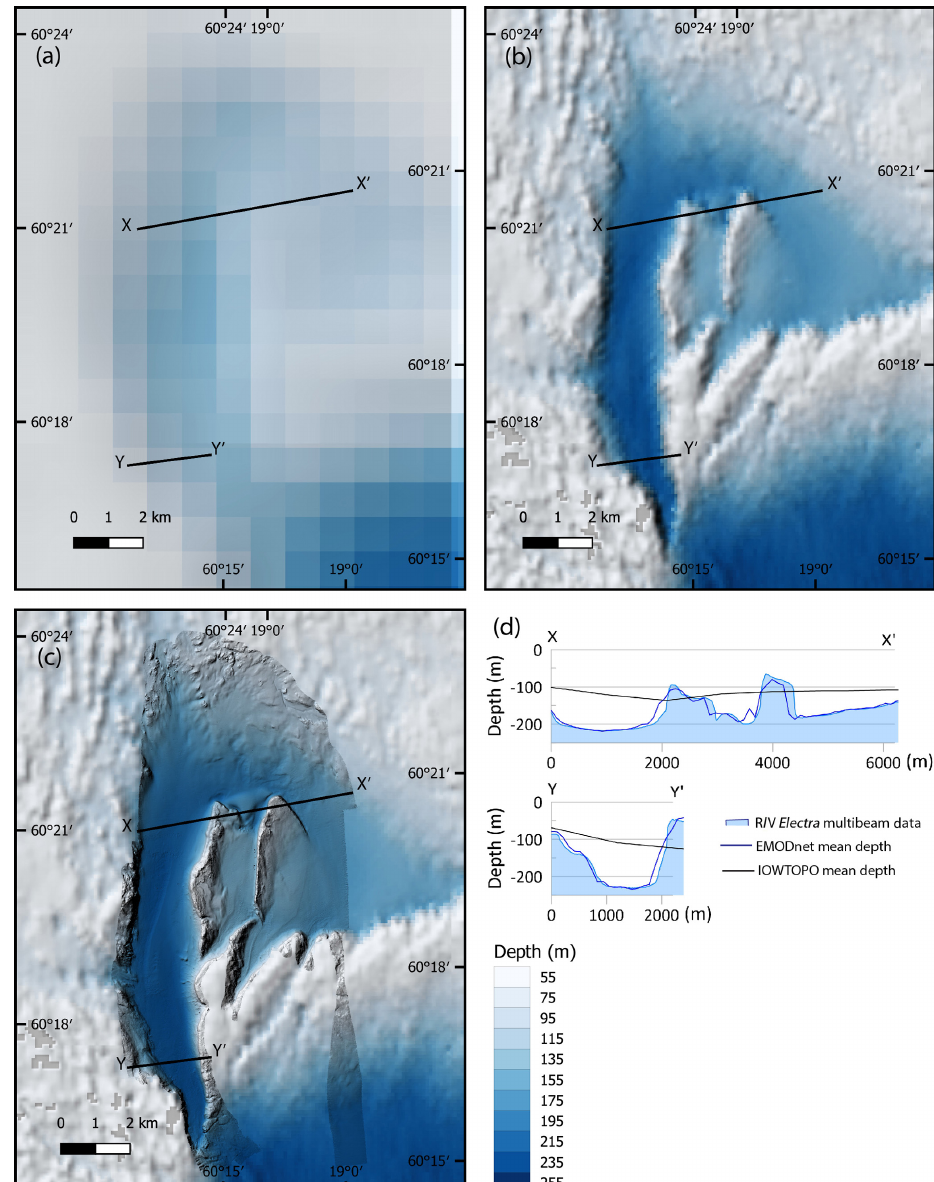
Figure 6. Bathymetry of the Southern Quark area based on IOWTOPO (a) , EMODnet (b) , and multibeam bathymetry acquired with R/V Electra (c) . (d) Bathymetric profiles X–X (cid:48) and Y–Y (cid:48) , drawn using the three different bathymetric datasets for comparison, show good correspondence between the R/V Electra multibeam and EMODnet mean depth, but extremely poor capture by IOWTOPO of ridges and channels relevant to water and sediment